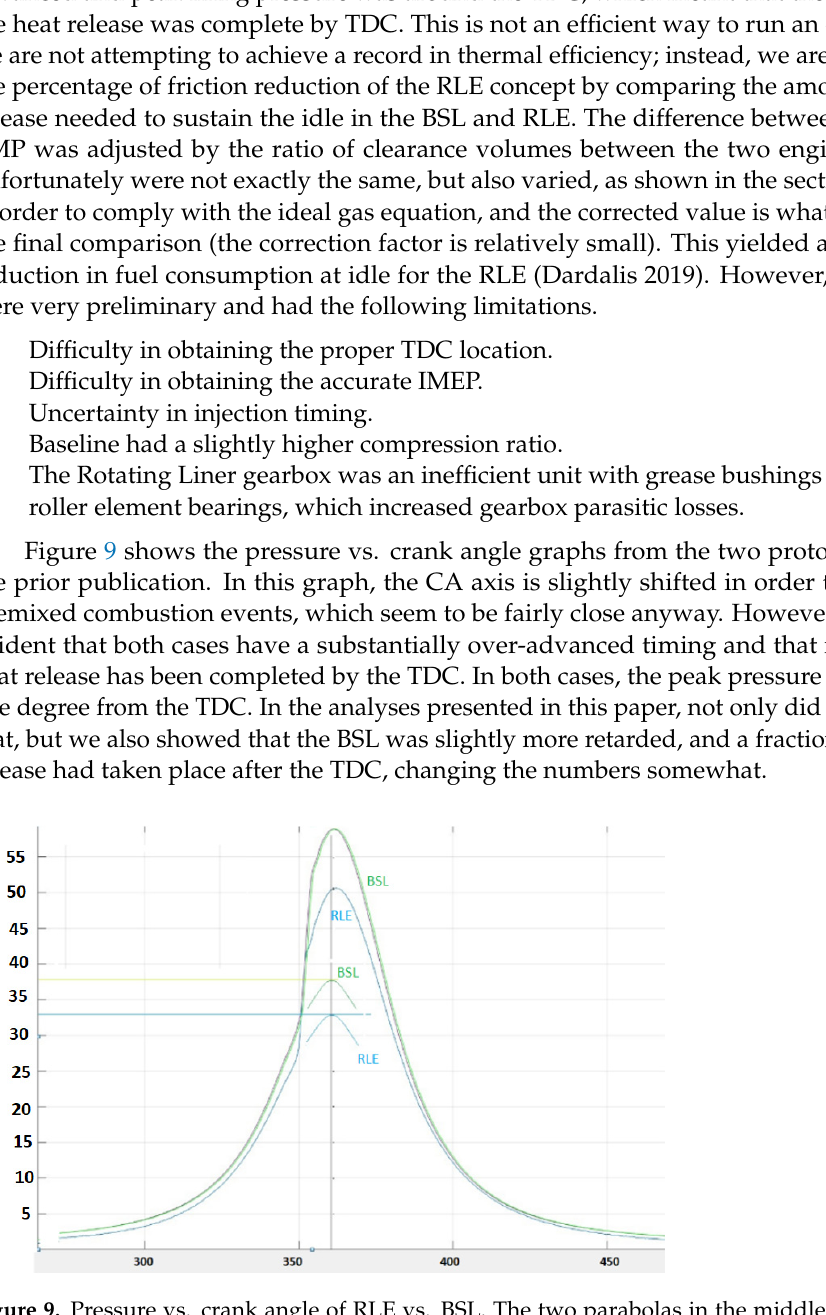
Figure 9. Pressure vs. crank angle of RLE vs. BSL. The two parabolas in the middle indicate the approximate peak of the motoring pressure.